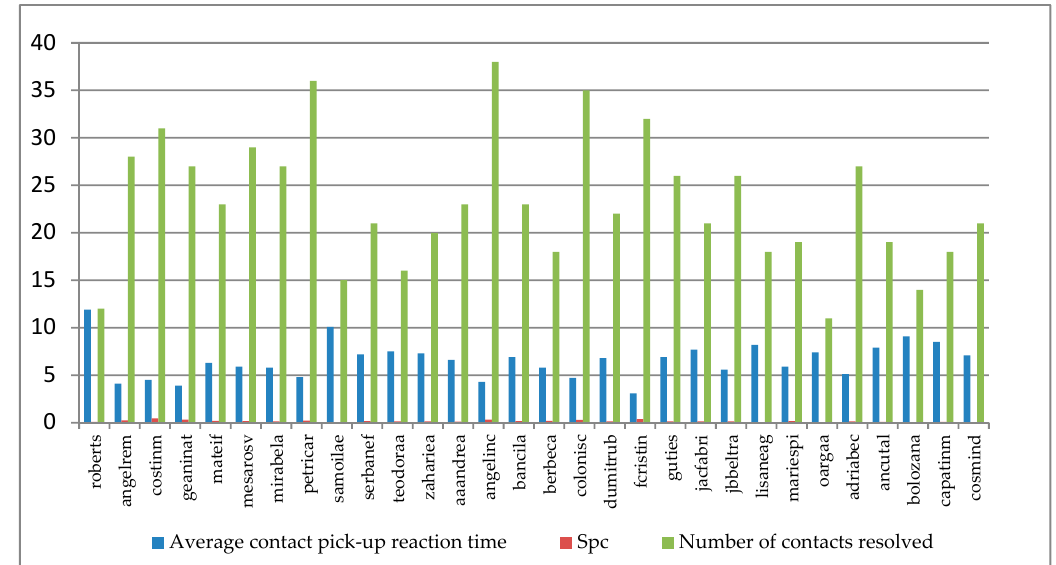
Figure 2. January benchmarking.